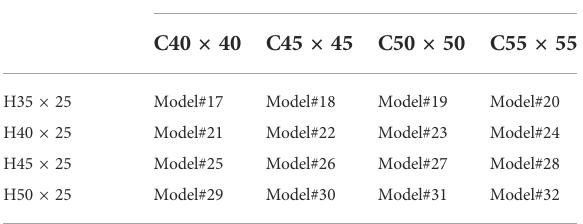
TABLE 1 List of drop beam models. Beam section Column